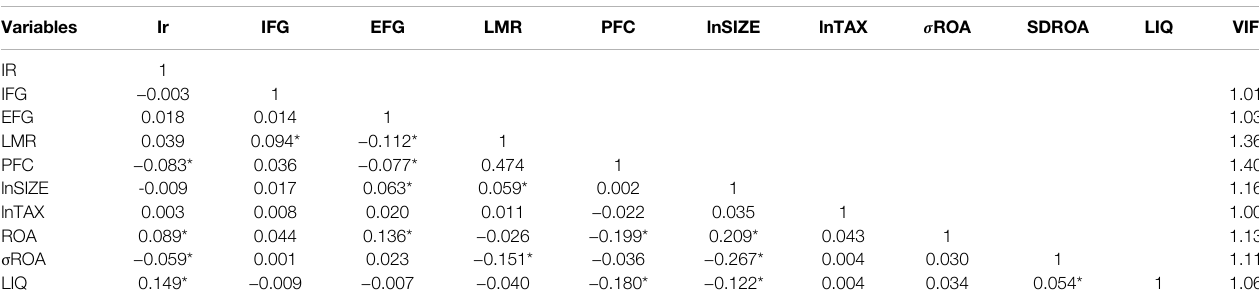
TABLE 3 | Results for Pearson correlations and